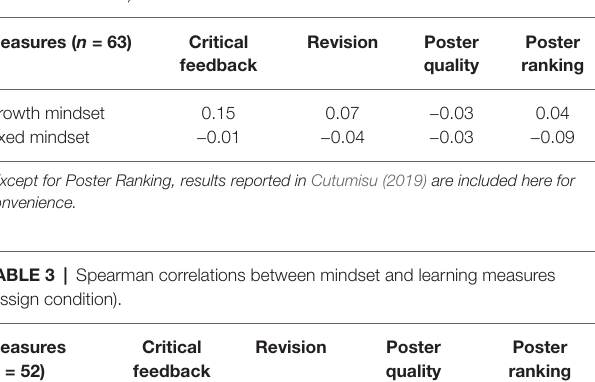
TABLE 2 | Spearman correlations between mindset and learning measures (Choose* condition).